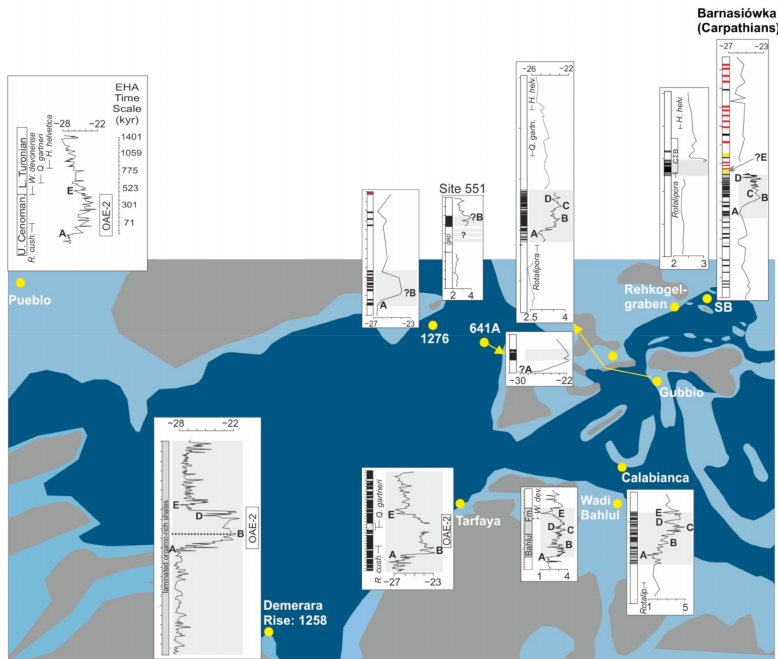
Figure 5. The selected deep-water and neritic sections containing the organic-rich facies in the CTBI, interpreted on the basis of the carbon stable isotope data. Palaeogeographical map of the Western Tethys after [65]. Carbon isotope curves after [44,51] (Pueblo), [44] (Wadi Bahlul), [53,54] (Calabianca), [48] (Site 1285), [45] (Gubbio, Tarfaya), [62] (Site 550), [46] (Lambruisse), [52] (Rehkogel graben), this article (Barnasi ó wka, Outer Carpathians). SB–Silesian